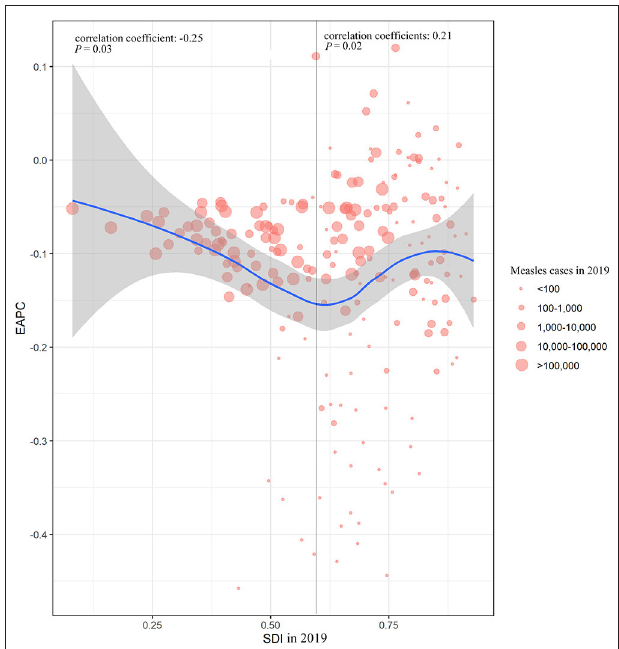
FIGURE 3 | The correlation between measles EAPC and SDI in 2019 at national level. EAPC, estimated annual percentage change; SDI, socio-demographic